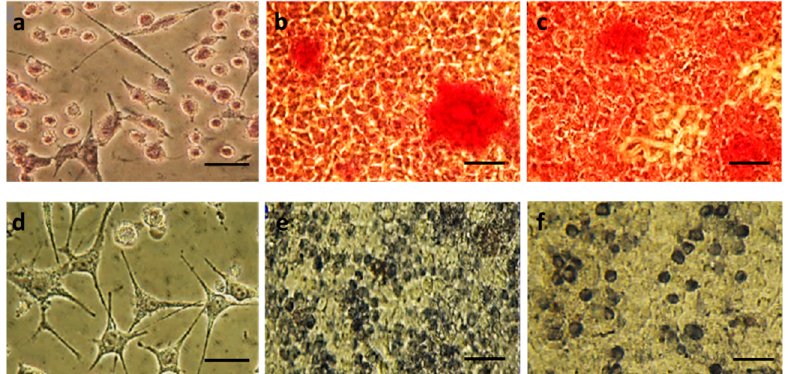
Figure 4. MRC-5 cells treated with biotinylated aza-reversine 2. The differentiation to osteoblasts was determined with alizarin red staining ( a – c ) and alkaline phosphatase assay ( d – e ). The control cells ( a , d ) did not change their shape and were neither stained positive in both assays. The calcium deposits were positively stained in MRC-5 cultures that were treated with biotinylated 2 ( b , c ). Alkaline phosphatase staining ( e , f ) of treated MRC-5 cells confirmed the alizarin red staining findings. Scale bars: 0.2 μ m.